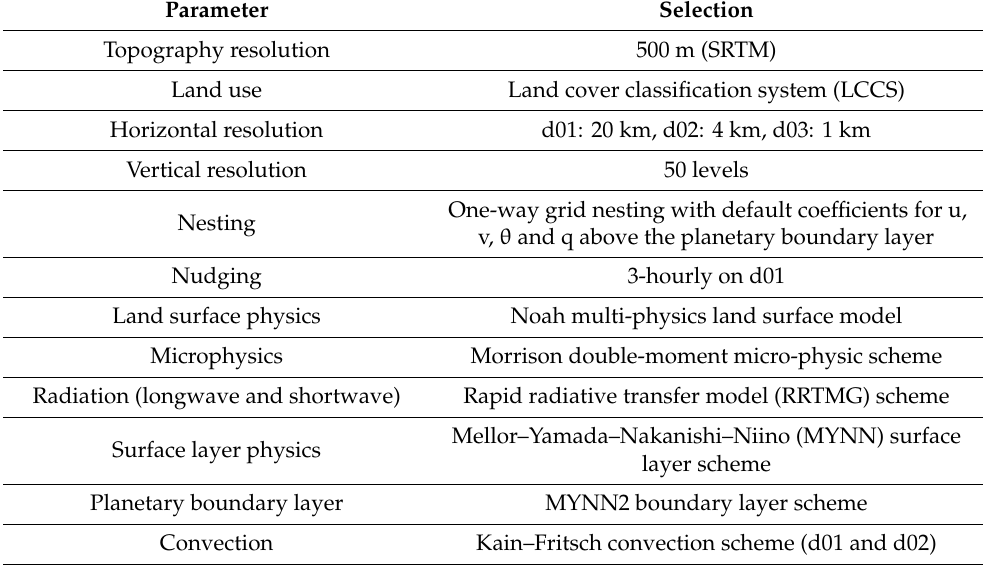
Table 3. WRF model